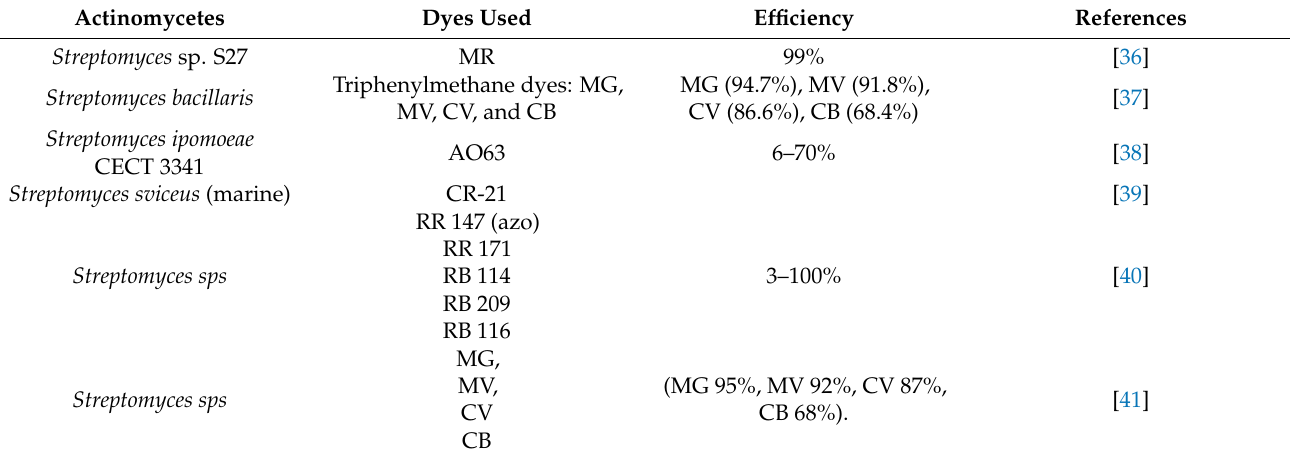
Table 1. Degradation of dyes by using